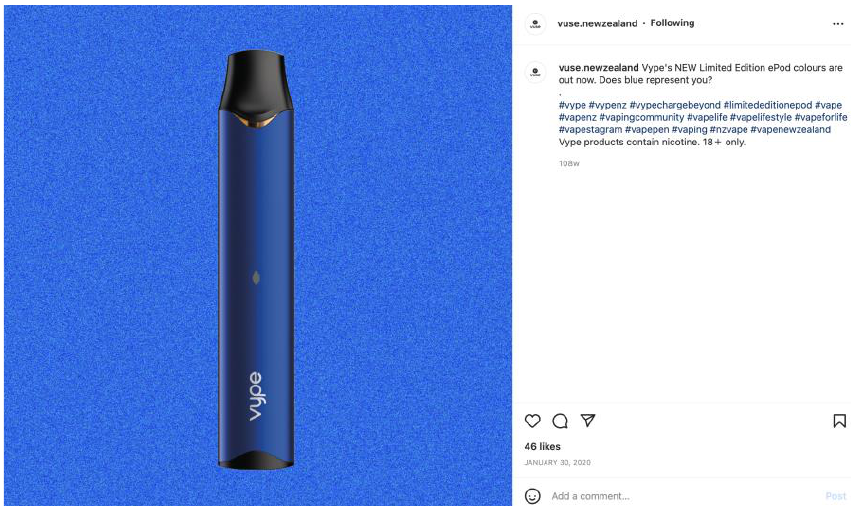
Figure 2. Example of an Instagram post promoting a personalised style feature.